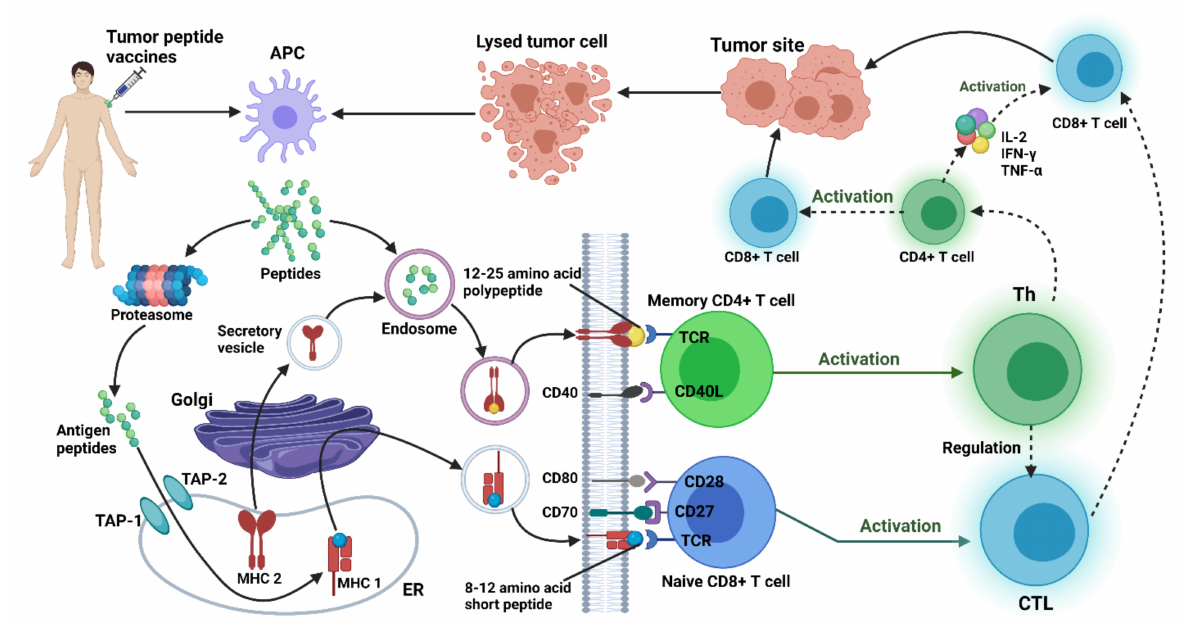
Figure 2. Tumor peptide vaccines have an immune system that activates T cells. Mature APCs may recognize and take up exogenous antigens when patients receive injections of the cancer peptide vaccines and the antigens enter the body. These are the main immunological reactions: (1) the proteasome converts proteins into small peptides that are sent to a transporter involved in the processing of antigens (TAP). The endoplasmic reticulum then binds 8–12 amino acid peptides to MHC–I (ER). (2) Following endocytosis, the antigenic polypeptides are broken down into endosomes. The resulting 12–25 amino acid peptides then interact with MHC–II, which was formed in the ER and discharged by the Golgi as vesicles. (3) The T cells become activated after recognizing and engaging the peptide-MHC complex via T cell receptors once the antigens are presented by APCs to lymphoid organs (TCRs). In the procedure, CD4+ T cells detect long polypeptides and the CD8+ T cells recognize short peptides. (4) Peptide-MHC complexes and costimulatory molecules operate as dual signals to activate immature CTLs from immature CD8+ T cells. To begin an efficient killing response, CTLs first travel to cancer locations. These cells produce a wide range of cytokines, including perforins and granzymes, as well as inflammatory mediators that dissolve target cells. (5) To maintain the expansion and proliferation of CD8+ T cells and support their antitumor effects, activated CD4+ T cells released cytokines such as IL-2, IFN-, and TNF. (6) Tumor antigens are further exposed by fragments released by tumor cell lysis, activating APCs and fostering antitumor immune